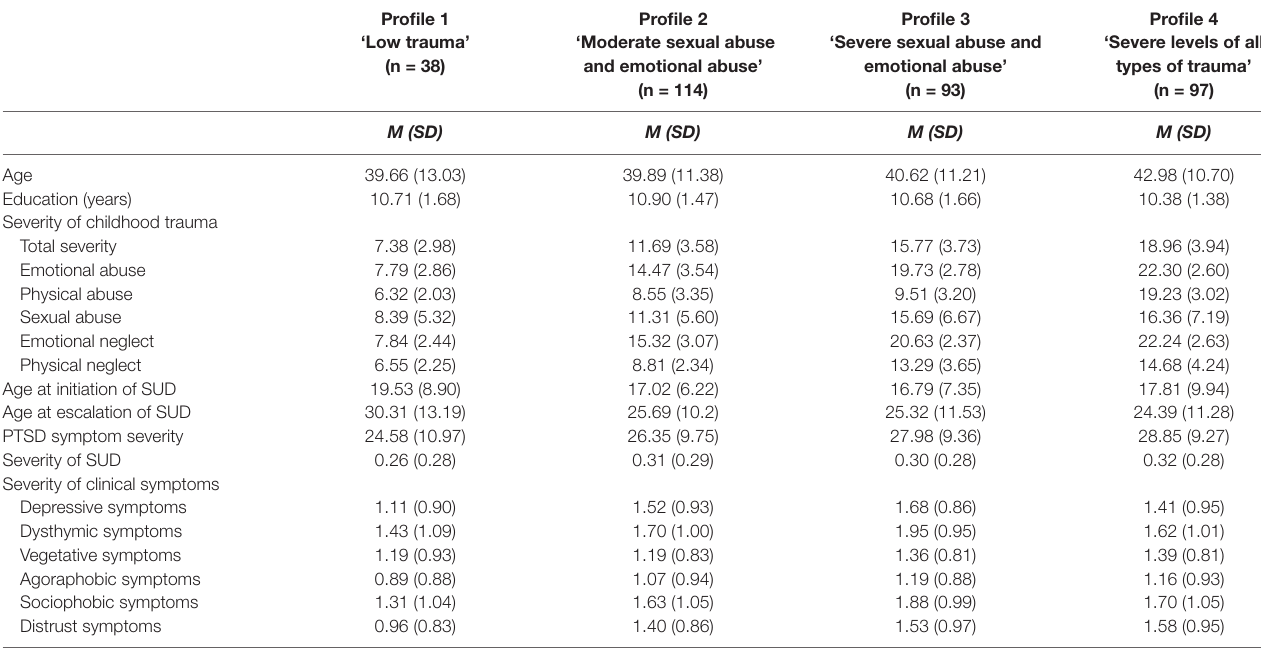
TABLE 2 | Clinical and sociodemographic characteristics of childhood trauma profiles (N = 343).